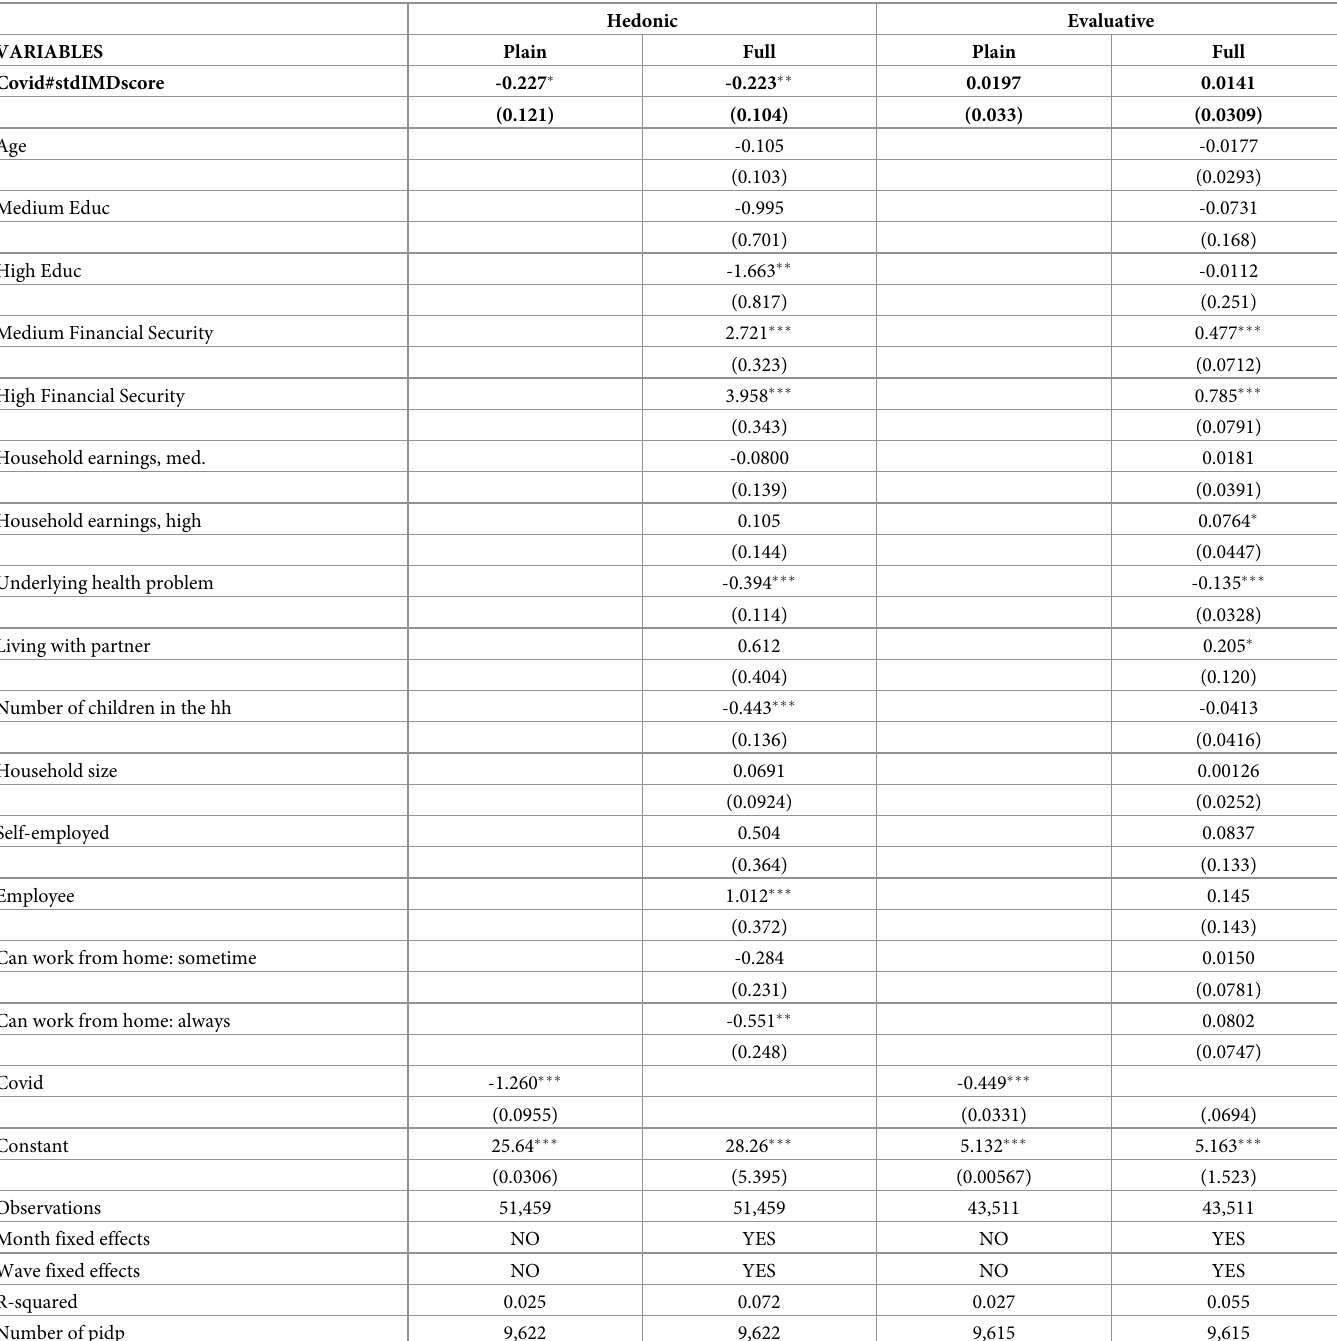
Table 4. Hedonic and Evaluative Well-being, Fixed-effects model, Difference-in-differences across the Covid-19